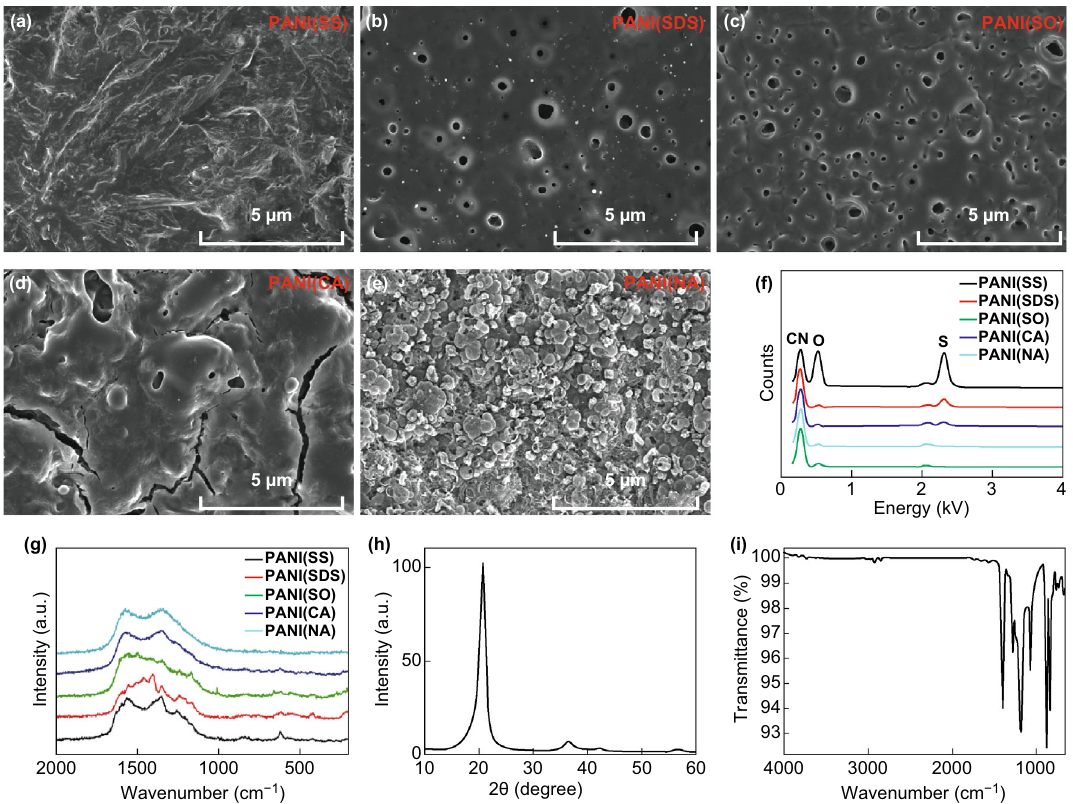
Fig. 2 Characterization of the PANI/PVDF. a – e SEM images of PANI(SS), PANI(SDS), PANI(SO), PANI(CA), and PANI(NA), respectively. f EDS spectra of the five PANI derivatives. g Raman spectra of the five PANI derivatives. h XRD pattern of PVDF film. i FTIR spectrum of PVDF